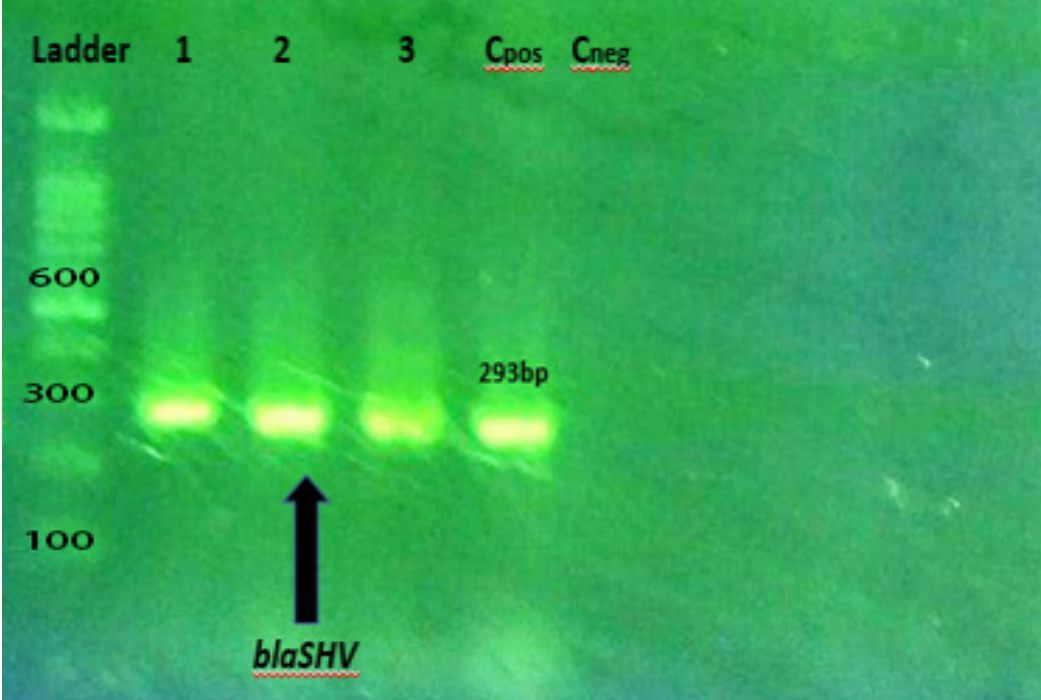
Figure 2. The result of PCR for bla C-pos: Positive control, C-neg: Negative control, Left line: 100bp DNA ladder, Line 1, 2 and 3: Positive SHV isolates (293bp).